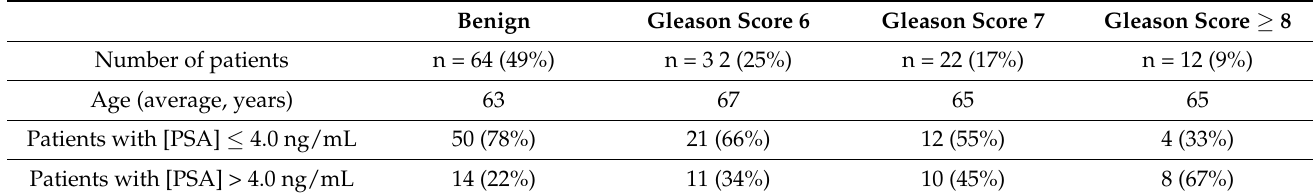
Table 2. Clinical characteristics of prostate patient samples. Gleason Score